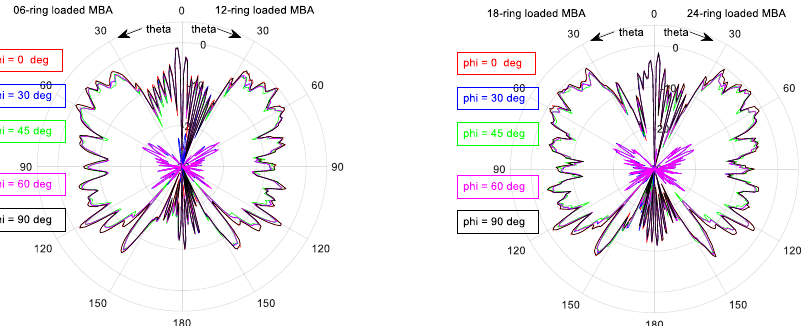
Figure A11. 2D patterns at 67 GHz of 6-, 12-, 18- and 24-ring-loaded MBA in different cutting planes.